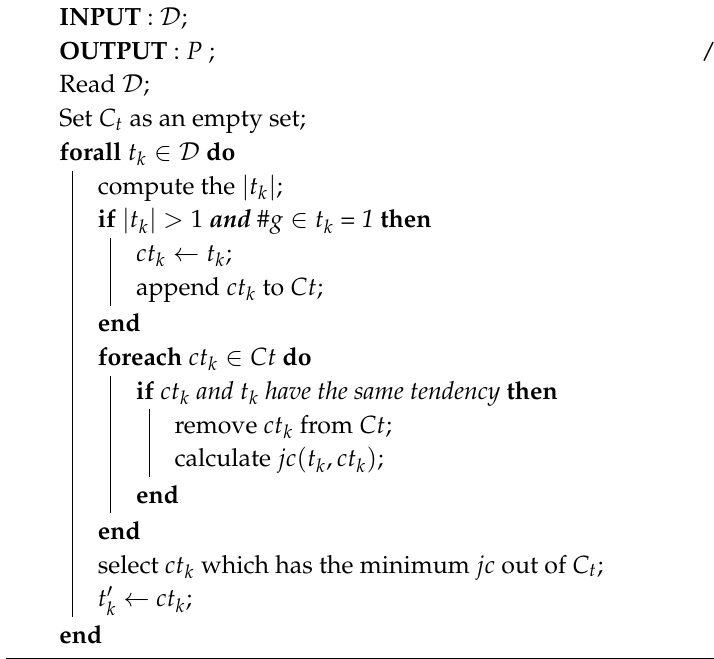
Algorithm 4: Procedure of destination record selection for full